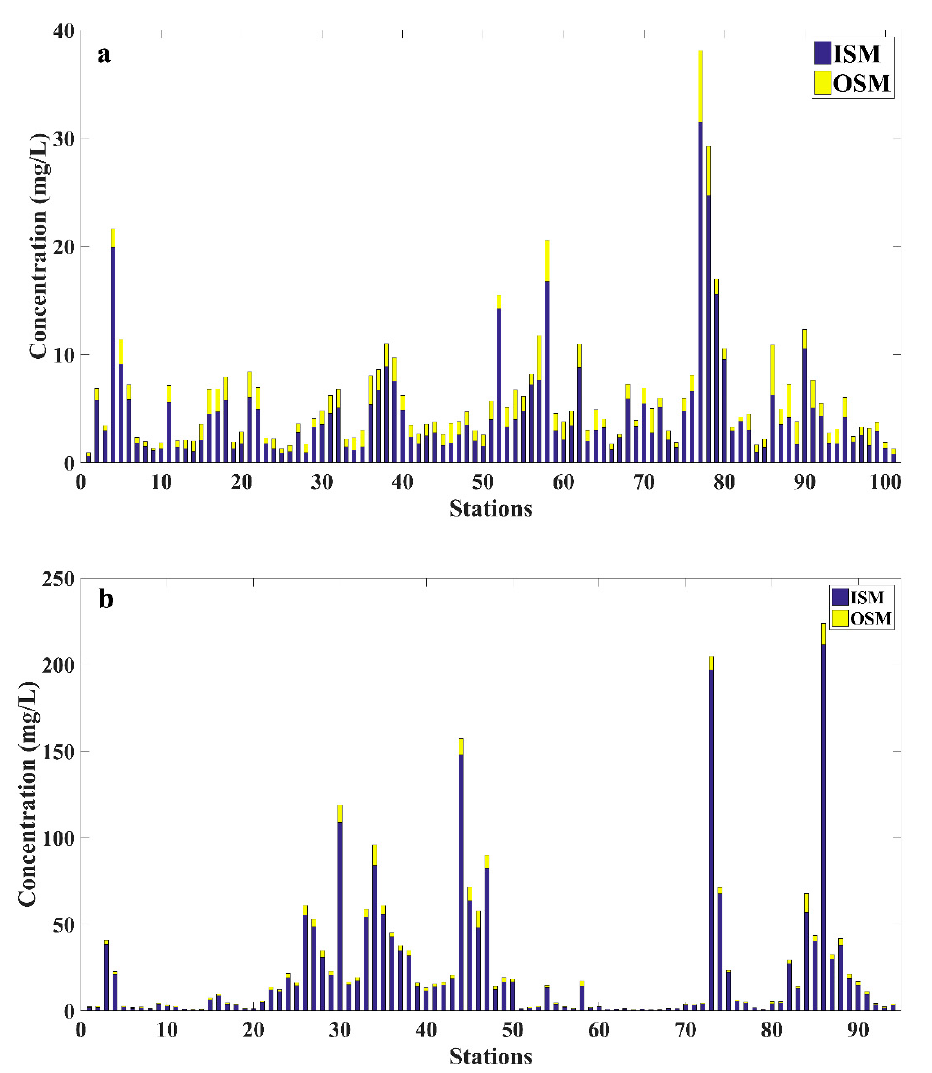
Figure 8. The organic suspended matter (OSM) and inorganic suspended matter (ISM) concentration in each station for ( a ) summer; ( b ) winter.